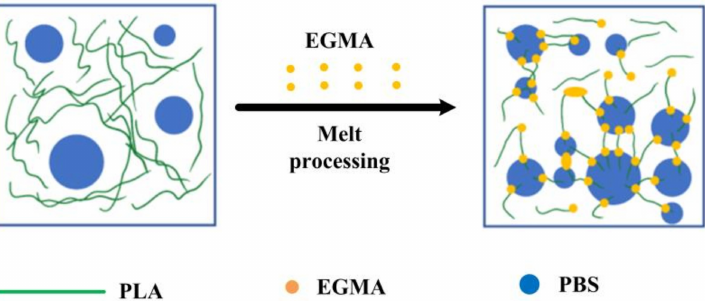
Figure 8. Schematic illustration of the morphology evolution PLA/PBS blend with the inclusion of